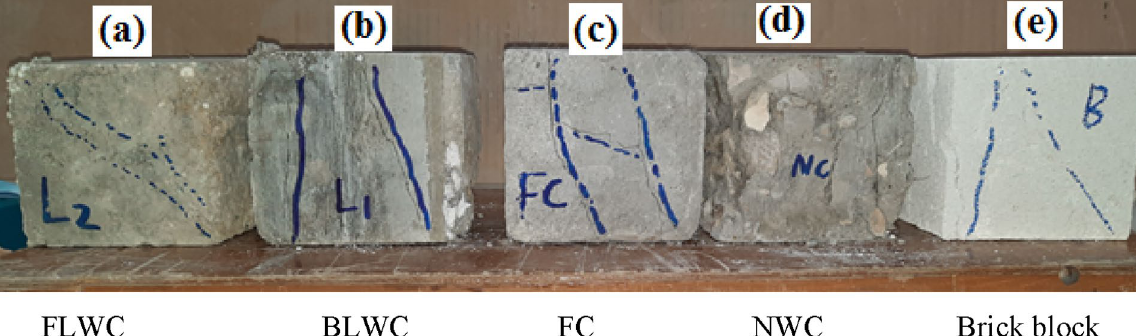
Fig. 4 Compression failure modes of all tested mixtures and brick block